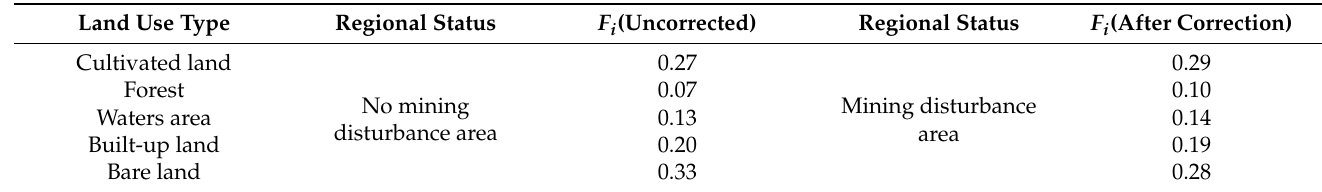
Table 4. Consultation results of experts on the vulnerability of different land use